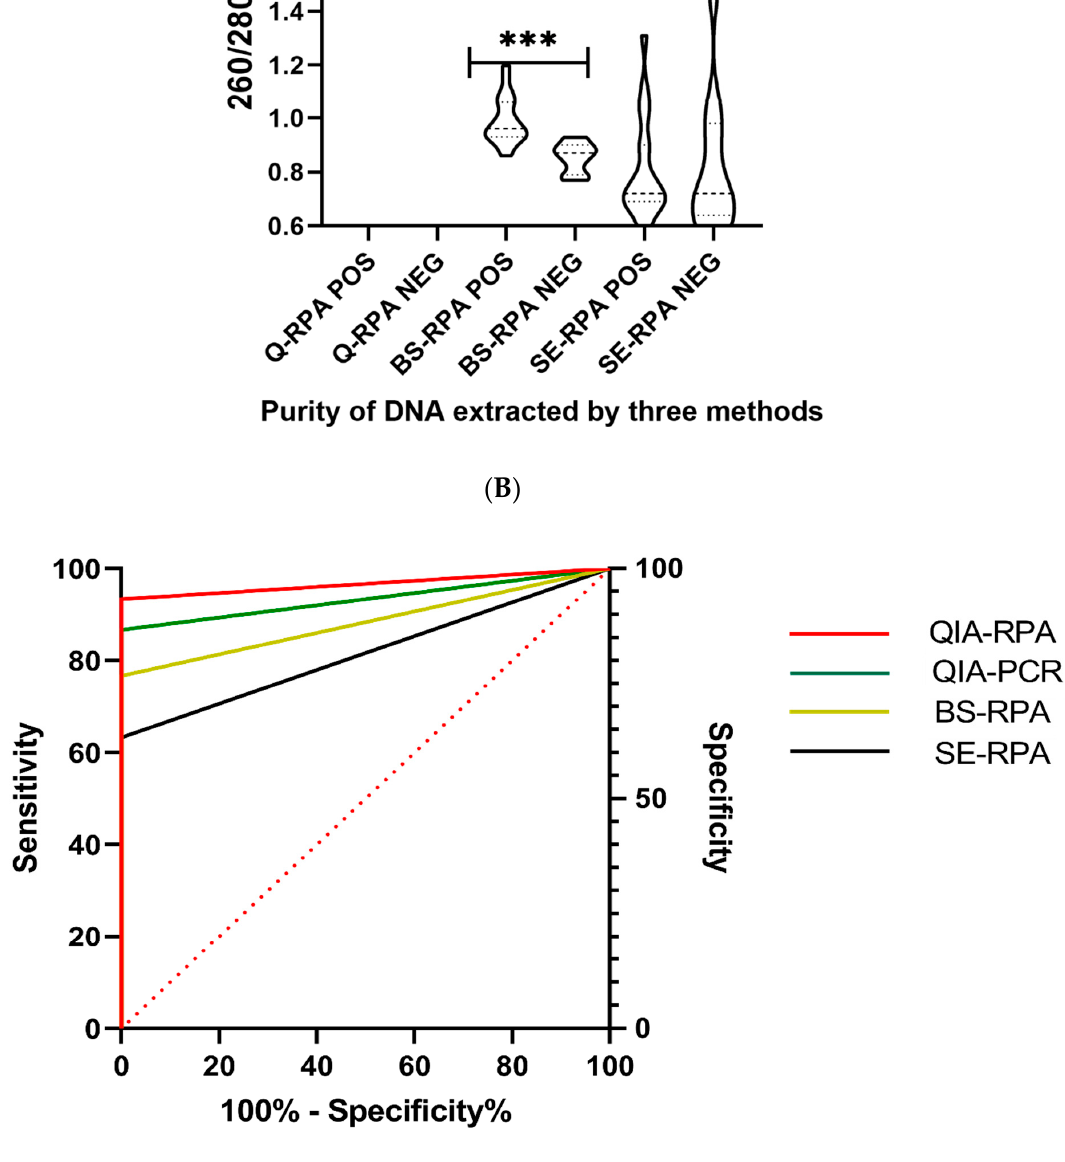
Figure 2. Illustration of the performance of three DNA extraction methods coupled with the RPA assay. In ( A ), the graph presents the concentration of DNA by the spin column (Qiagen), boil & spin, and SpeedXtract extraction methods, ** p < 0.001. In ( B ), the purity of DNA through the spin column (Qiagen), boil & spin, and SpeedXtract extraction methods is shown, *** p < 0.0001. In ( C ), the receiver operating characteristic (ROC) curve shows the diagnostic accuracy of the qPCR and RPA assays coupled with the spin-column-based (Qiagen), boil & spin, and SpeedXtract extraction methods for the detection of Leishmania parasites in skin biopsy